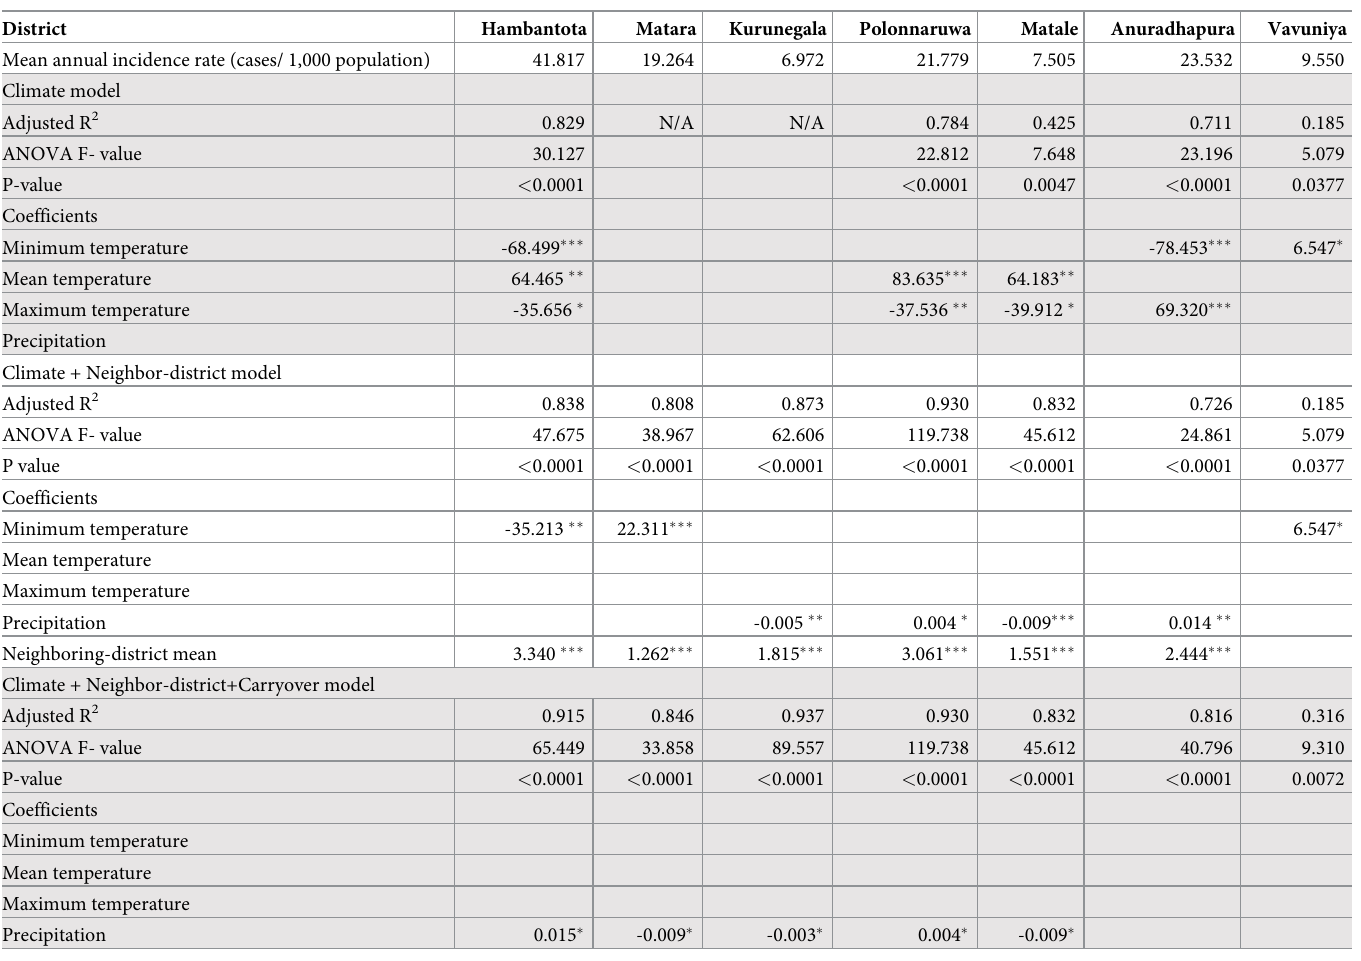
Table 1. Risk factors of clinical leishmaniasis in different districts.